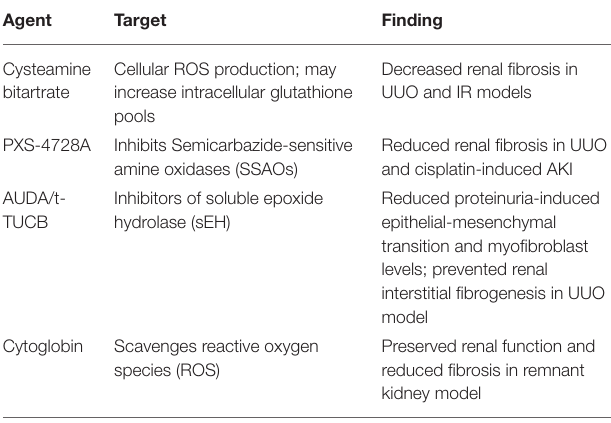
TABLE 1 | Novel anti-oxidative agents that ameliorate renal